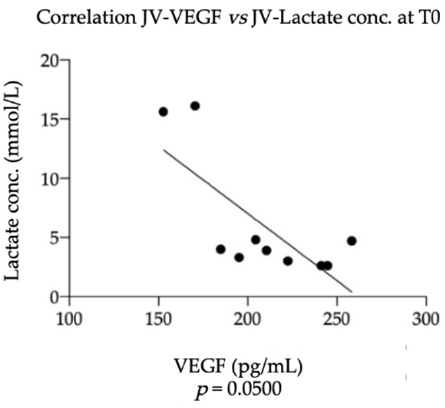
Figure 4. Significant correlation found between Vascular endothelial growth factor (VEGF) levels in plasma samples obtained from foal’s jugular vein and the lactate concentration at T0 ( p = 0.0500; r = − 0.6444). Statistical analysis: nonparametric Spearman correlation.